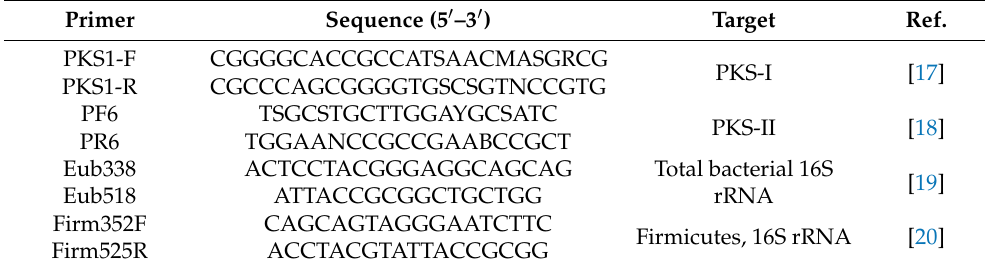
Table 1. List of primers used in the quantitative